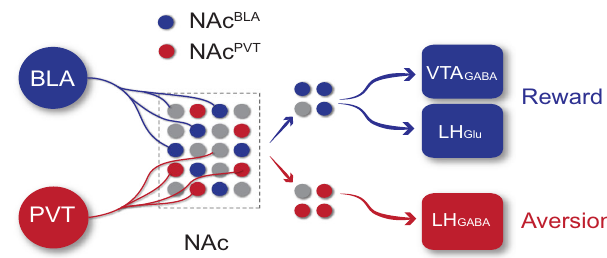
Fig.8|Schematicshowingrolesofinput-outputde fi nedparallelNAcpathways in reward and aversion processing. The NAc BLA neurons receive BLA inputs and project to VTA GABA and LH Glu neurons to control reward-seeking behavior. The NAc PVT neurons receive PVT inputs and project to LH GABA neurons to promote